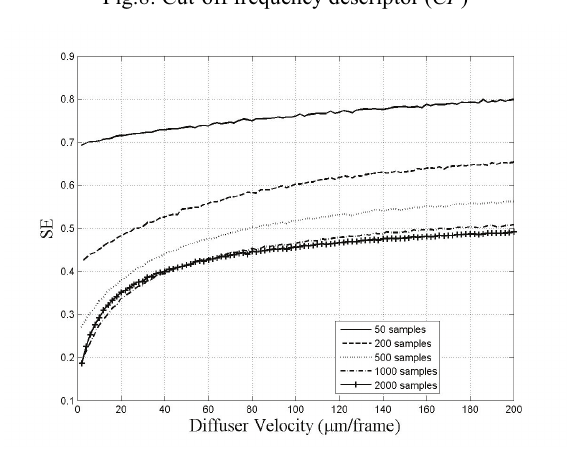
Fig.8: Cut-off frequency descriptor ( CF )